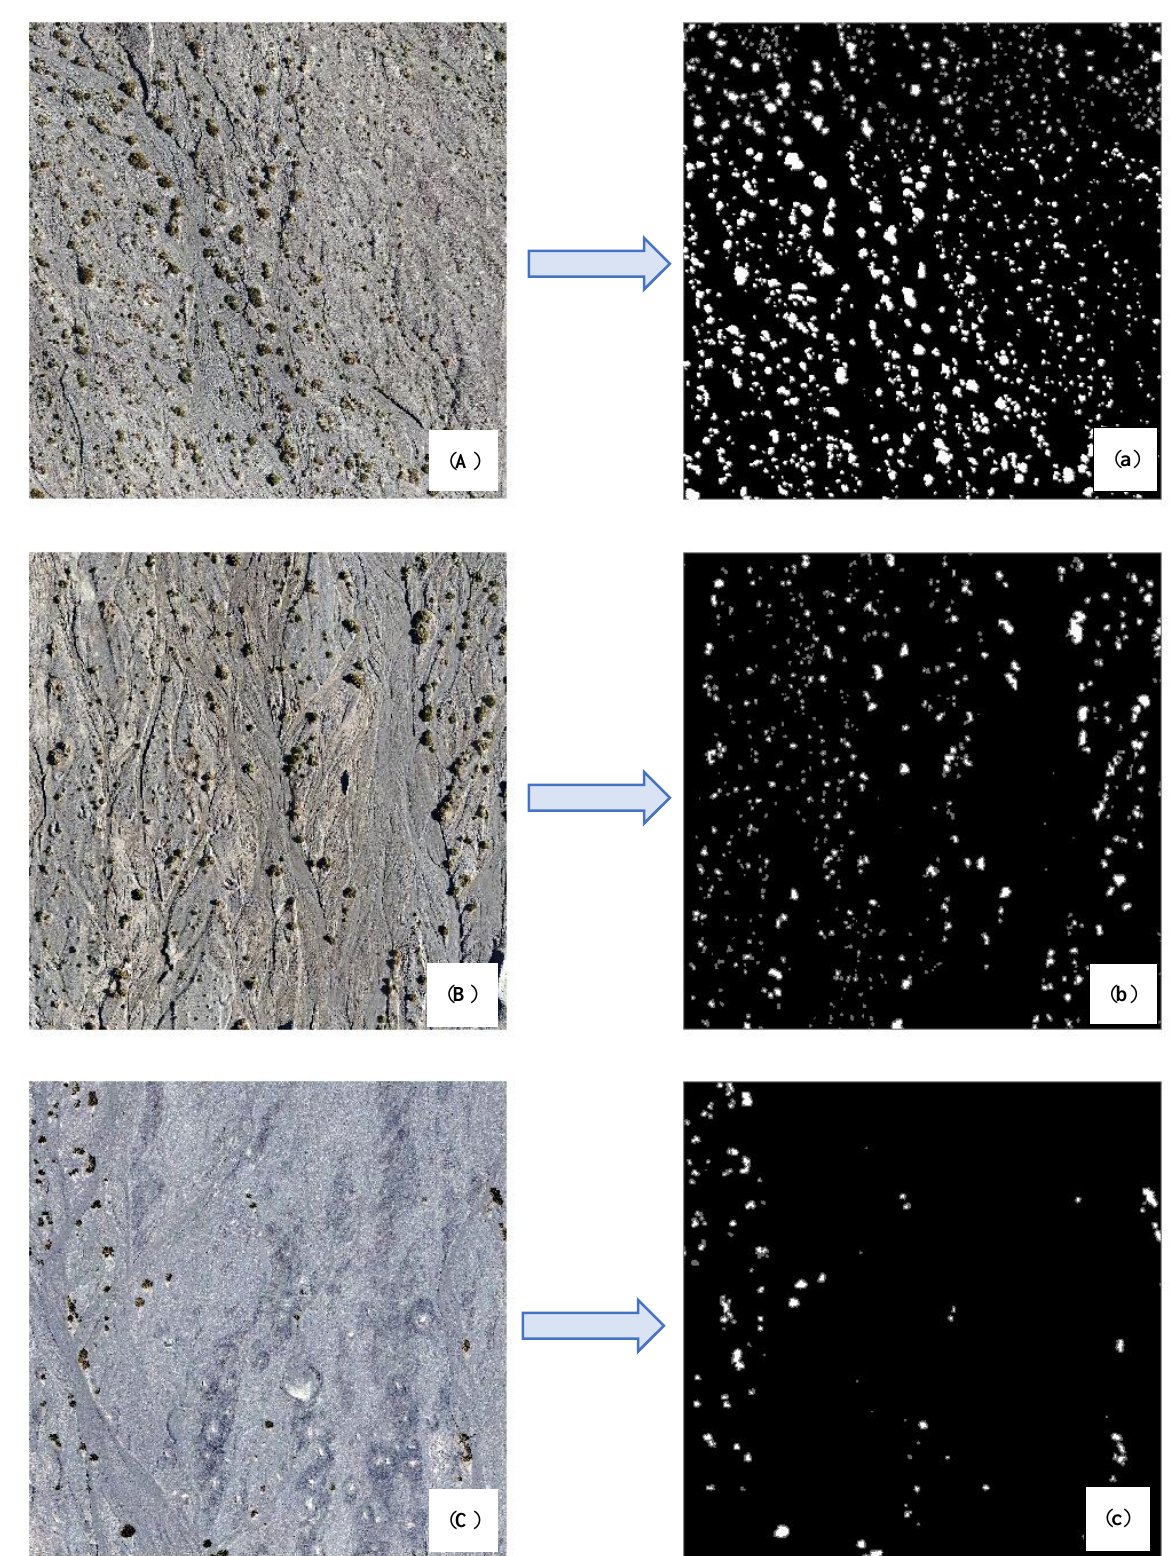
Figure 3. Vegetation coverage calculated based on EXG indices at different positions of the alluvial fan: ( A – C ) UAV orthophoto at the top, middle and bottom of the alluvial fan, respectively; ( a – c ) vegetation coverage at the top, middle and bottom of the alluvial fan, respectively, where the vegetation crown areas were white, the non-vegetation areas were black.